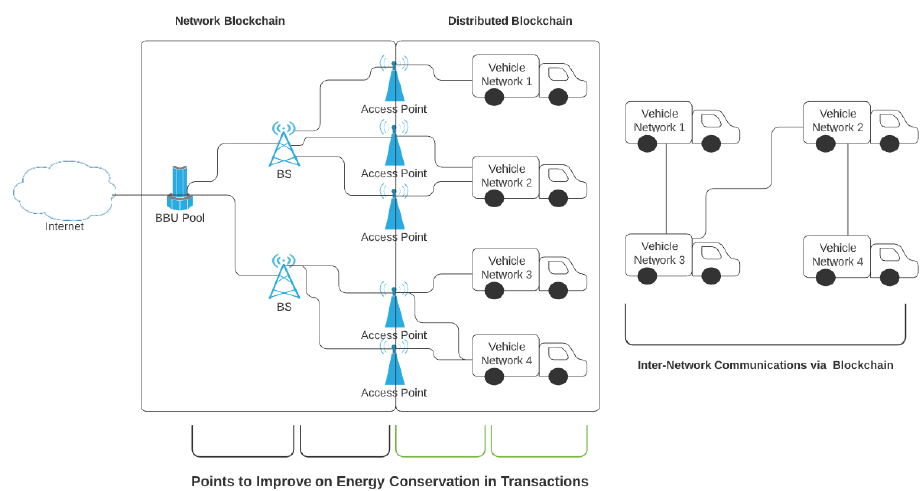
Figure 19. A model showing the structure of the areas of the CAVs network where energy use can be improved, inspired by